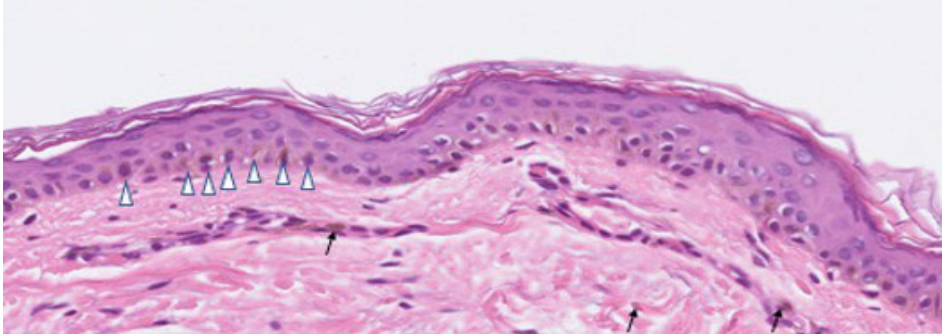
Figure 3. Histopathology features of Riehl’s melanosis showed basal cell vacuolization with necrotic keratinocytes, prominent pigment incontinence, melanin supranuclear cap (shown in ), and melanophages in the dermis (shown in arrow).